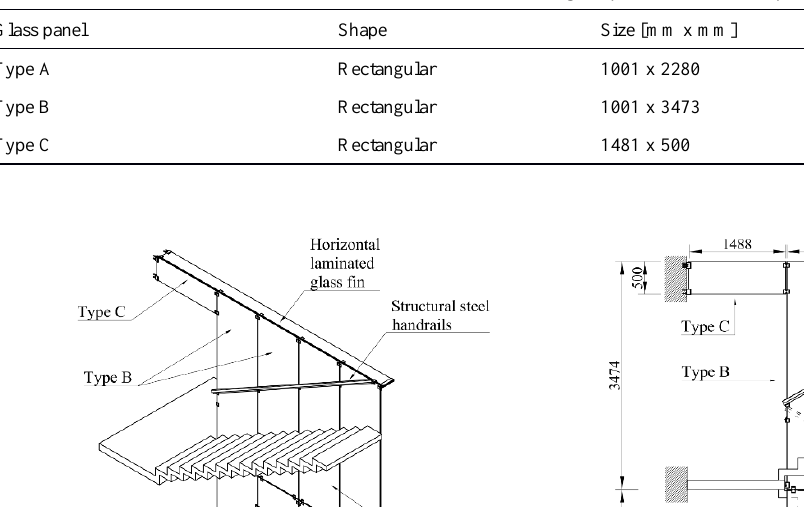
Table 1: Position of the laminated glass panels in the central